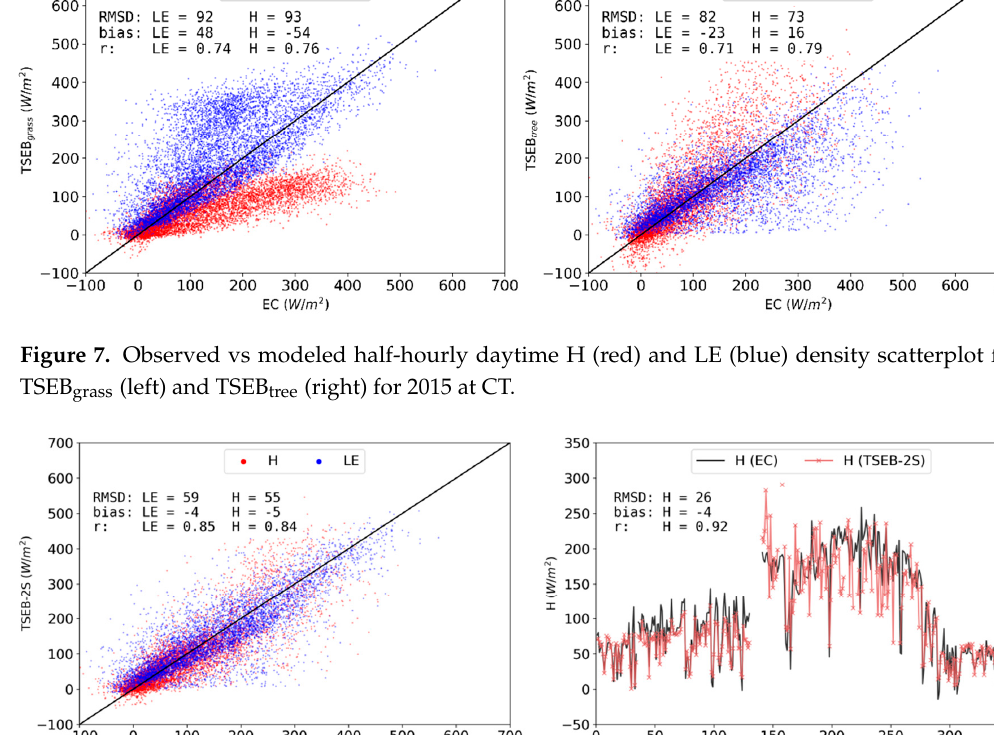
Figure 8. Observed vs modeled daytime half-hourly H (red) and LE (blue) density scatterplot (left) and time series of simulated (red) and observed (black) daytime daily mean H (right) for TSEB-2S simulations of 2015 at CT.